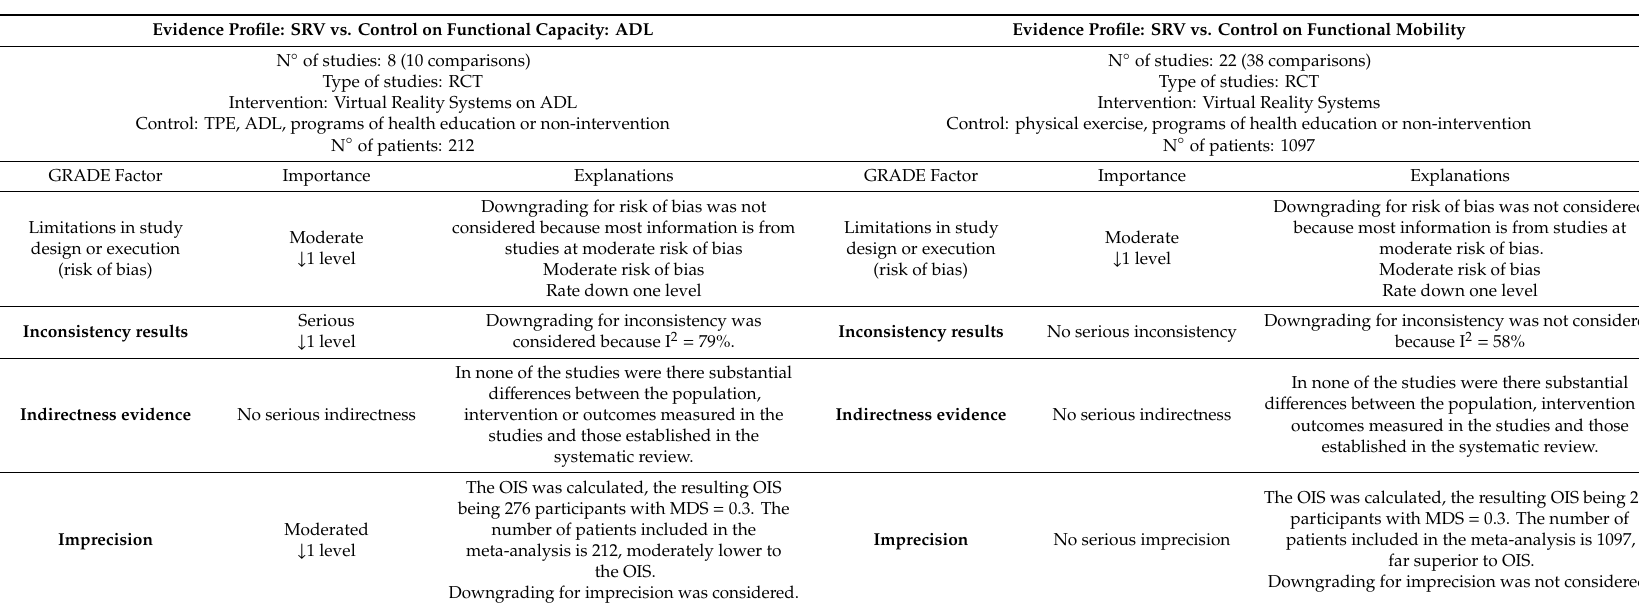
Table A3. Grading of Recommendations Assessment, Development and Evaluation (GRADE): Evidence Profile: SRV vs. control on functional autonomy: